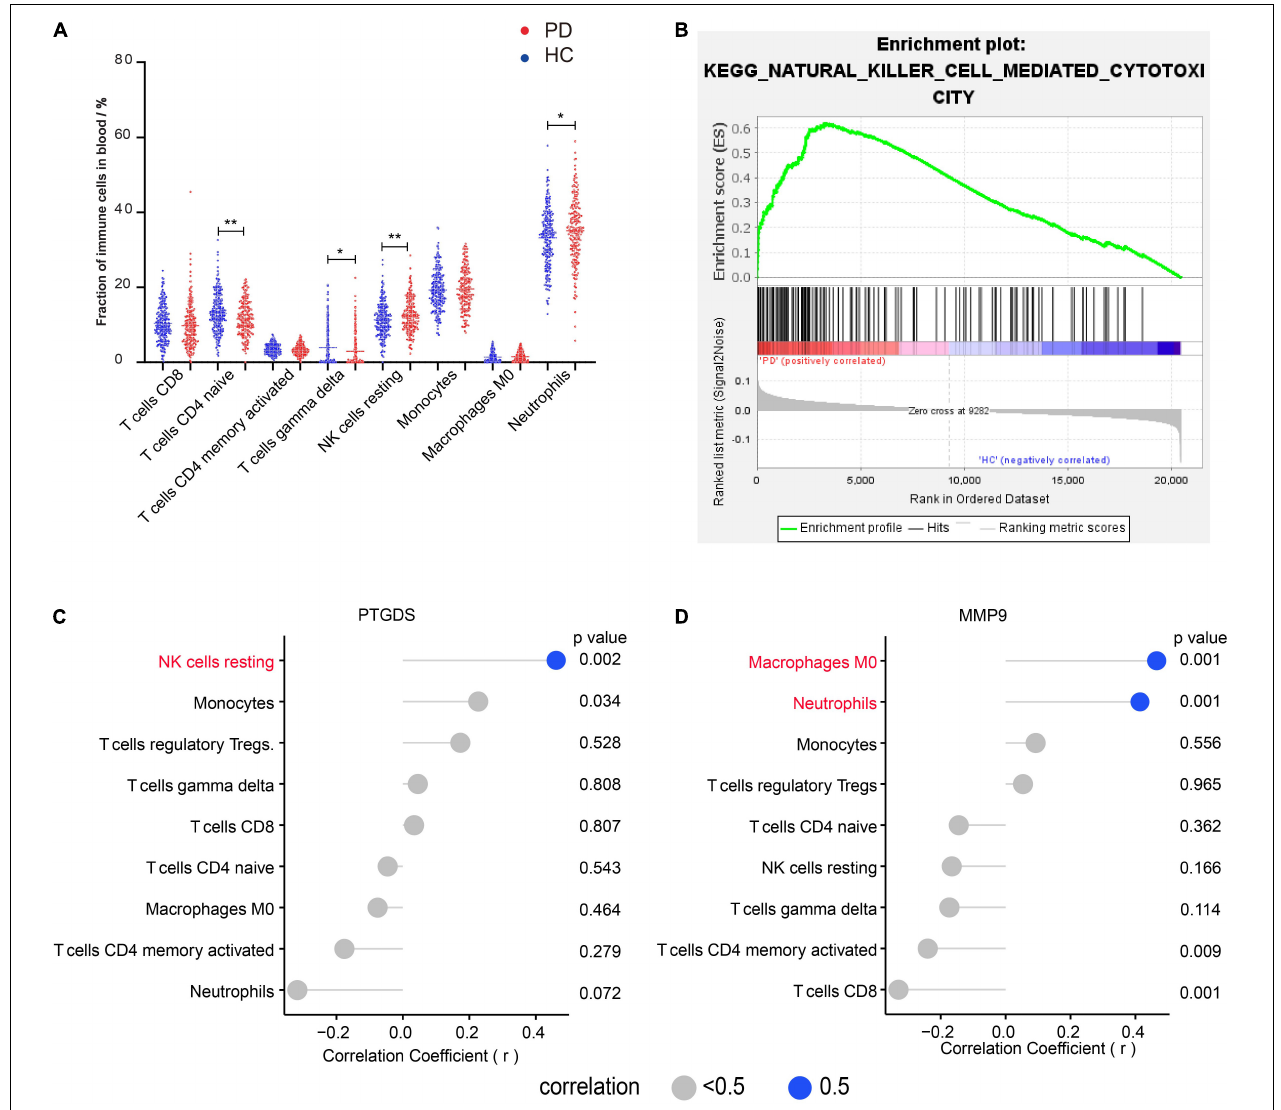
FIGURE 1 | Four immune cell fractions in the blood from PD compared with those from HC are significantly different and the correlation between immune cells and DEGs in the blood of patients with PD. (A) The main immune cell fractions in the blood from PD and HC. The ordinate represents the immune cell fractions, and the abscissa represents the immune cell types. The blue dots represent HC samples, and the red dots represent PD samples. (B) KEGG pathway–NK cell-mediated cytotoxicity enriched in PD using GSEA. (C) Correlation between PTGDS and immune cells. (D) Correlation between MMP9 and immune cells. * p < 0.05, ** p < 0.01.